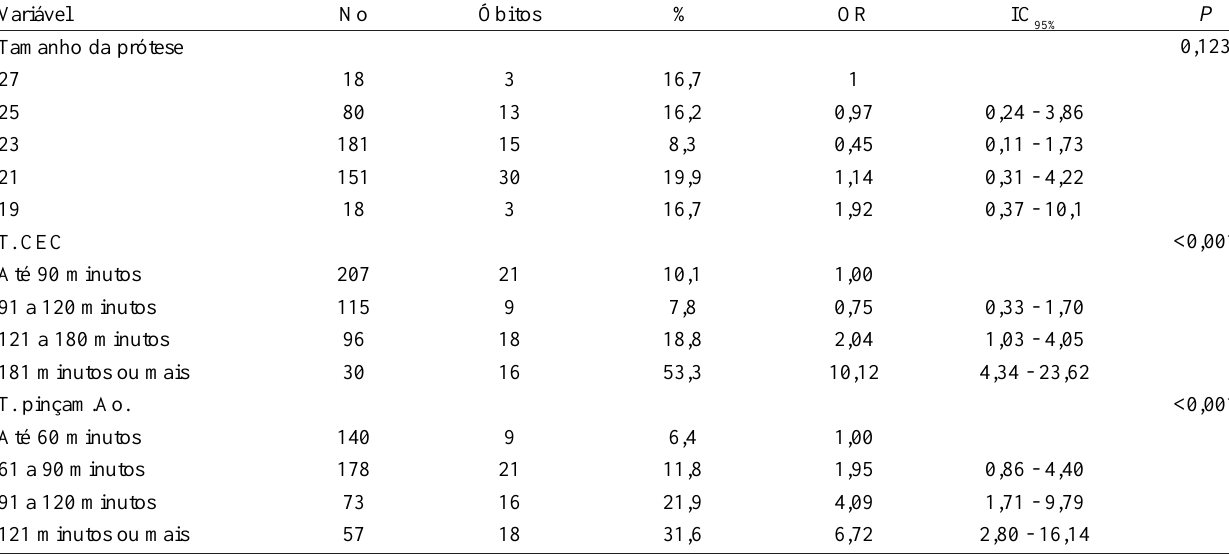
Tabela 4. Distribuição da mortalidade hospitalar do grupo G1, em função dos dados intra-operatórios. Variável